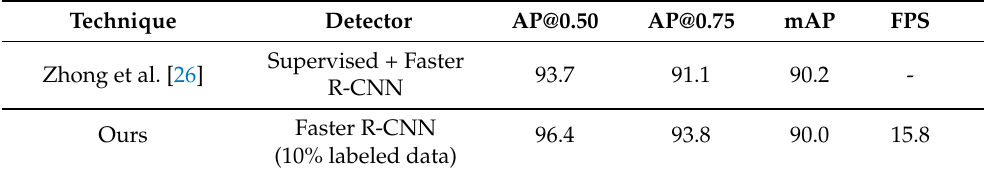
Table 6. Performance comparison of Faster R-CNN baseline model trained on fully labeled data with our semi-supervised model which is trained on 10% labeled PubLayNet dataset. The model uses Faster R-CNN and